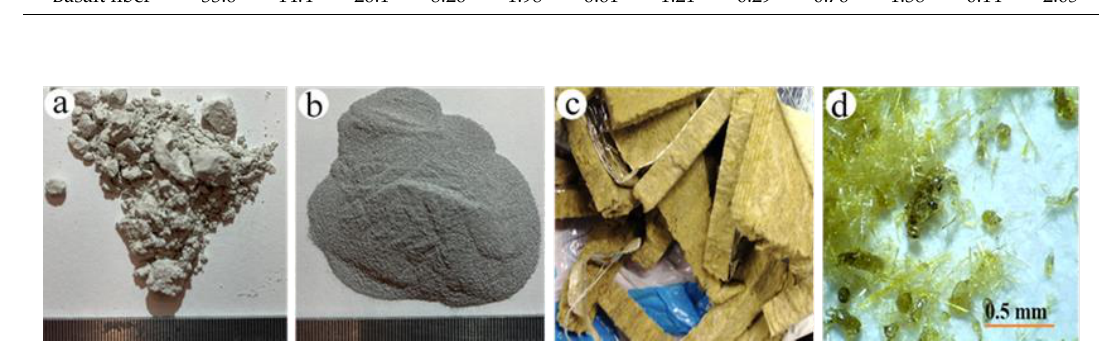
Table 1. Chemical compositions of geopolymer Baucis lk and basalt fiber (wt.%). Constituents